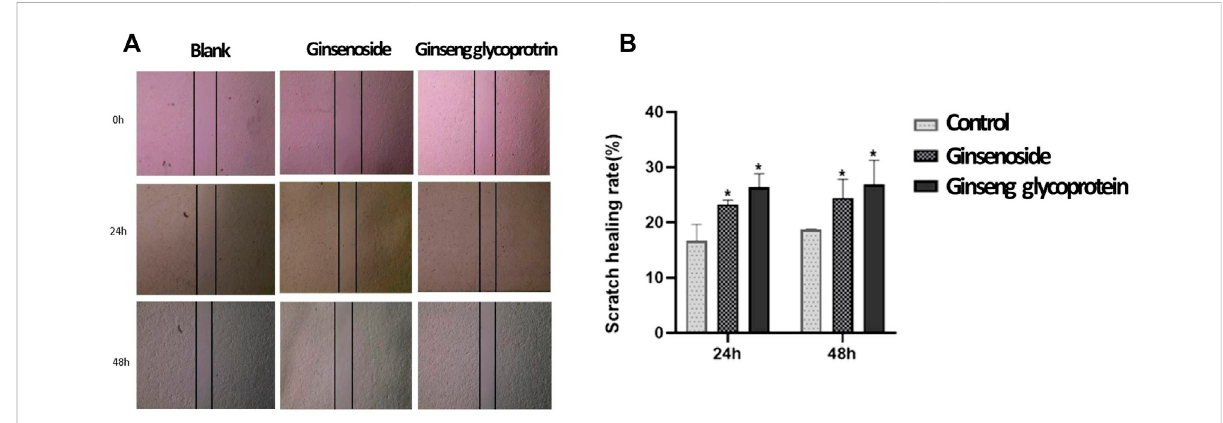
FIGURE 4 Ginsenoside and ginseng glycoprotein can promote HaCaT cell migration. (A) Ginsenoside and ginseng glycoprotein promote HaCaT cell migration. Scale bar: 200 μ m; (B) Quantitative analysis * p < 0.05, indicating a signi fi cant difference between control and treatment groups. Data are expressed as N =